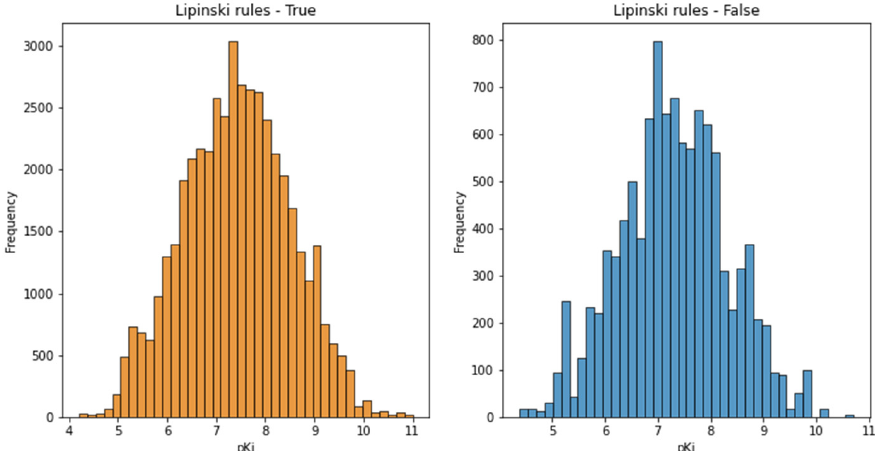
Figure 7. Histograms of pKi values for compounds that did and did not fulfill the rule of five. The correlation matrix for the six chemical descriptors (MW, nHBDon, SLogP, nHBAcc, TopoPSA, and nRot) and pKi with Pearson’s correlation coefficients are depicted in Figure 8. From the selected features, only the polar surface area (TopoPSA) and number of H-bond acceptors (nHBAcc) had a strong positive correlation.